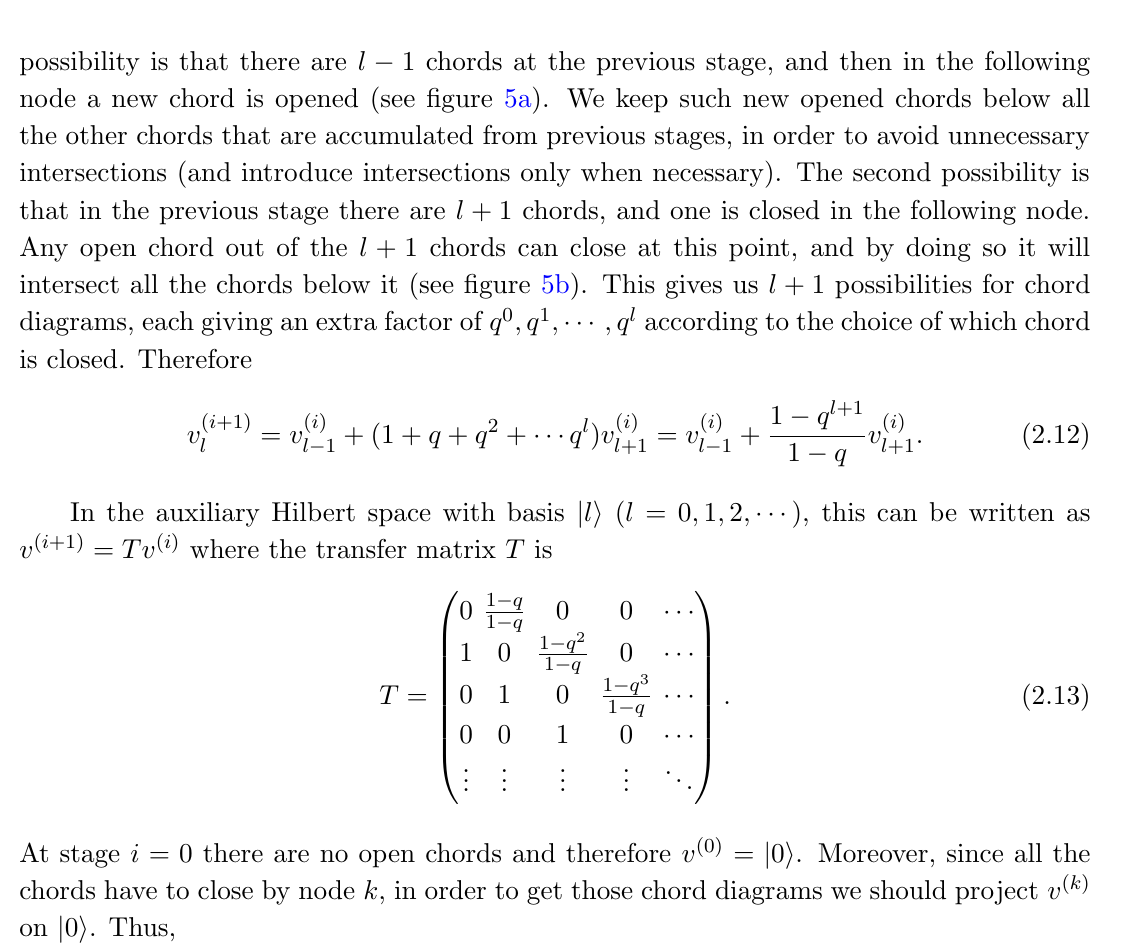
Figure 5. At any given node, either a chord opens (as in the left), or a chord is closed (as in the right), crossing all the chords below